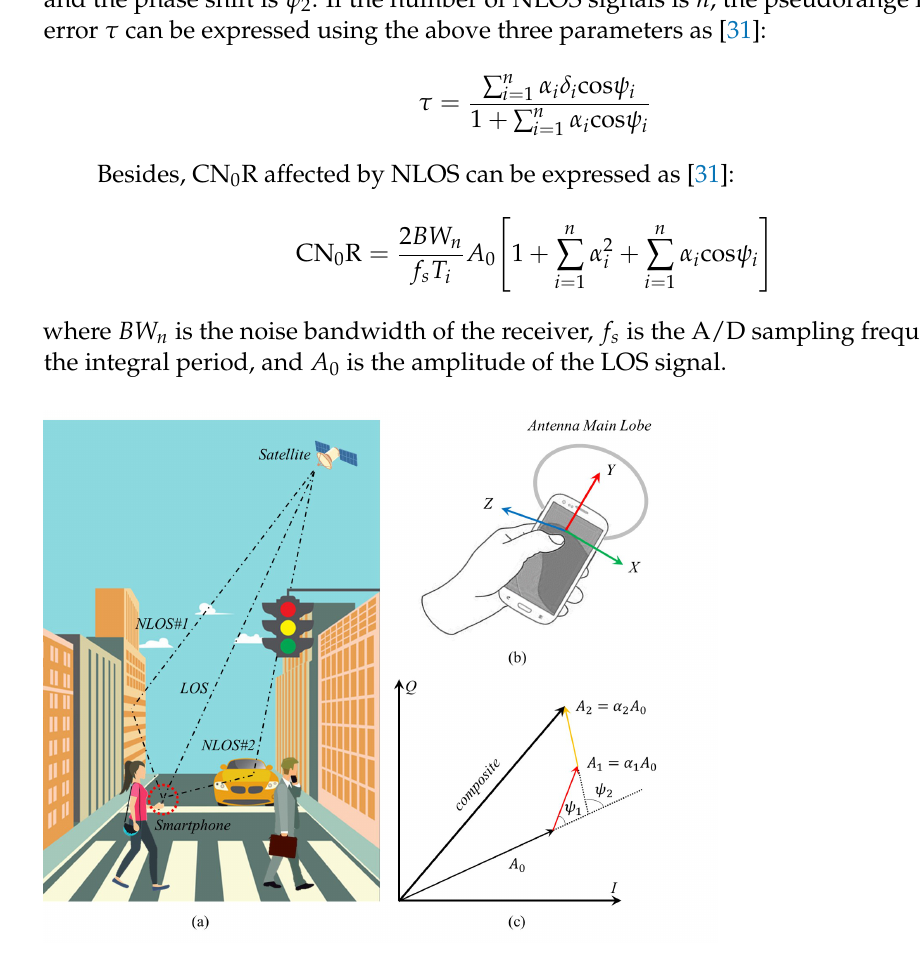
Figure 2. Multipath scene. ( a ) In urban streets, a pedestrian’s smartphone receives not only LOS from the satellite, but also NLOS (cid:93) 1 reflected from buildings and NLOS (cid:93) 2 caused by mobile vehicles. ( b ) This figure shows the coordinate axis of the 3-axis MEMS sensors and the main lobe of the GNSS antenna when a pedestrian holds the smartphone. ( c ) The composite signal in the IQ diagram of